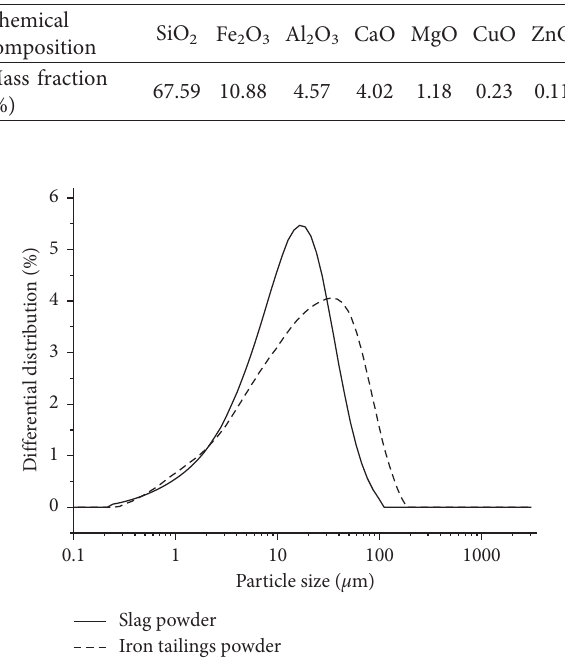
Table 2: Main chemical composition of iron tailings powder.